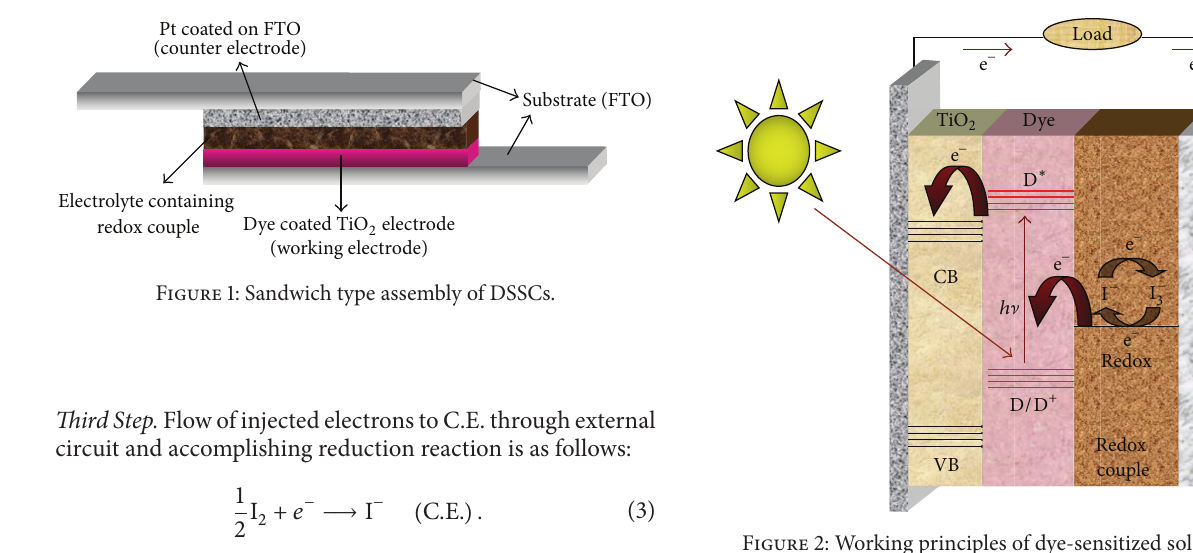
Figure 2: Working principles of dye-sensitized solar